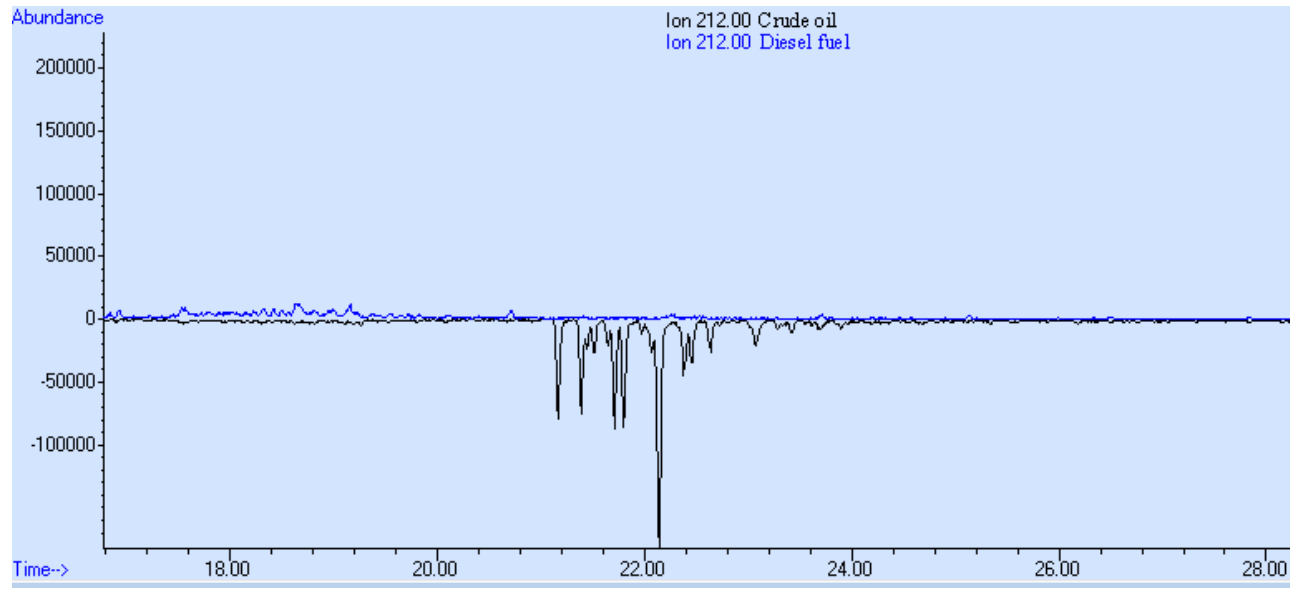
Figure 9. Comparison of EIC at m/z 212 between crude oil and diesel fuel samples.